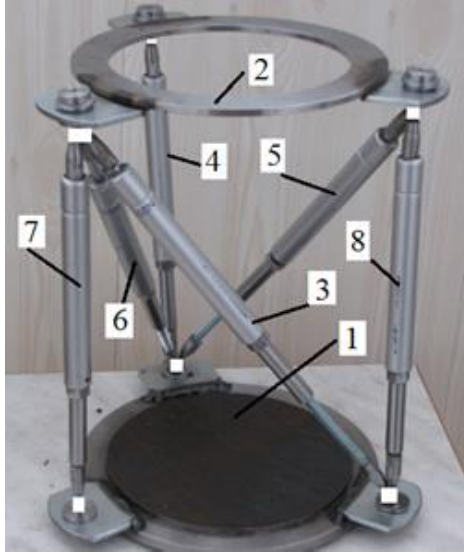
Figure 1. Primary manipulator converter